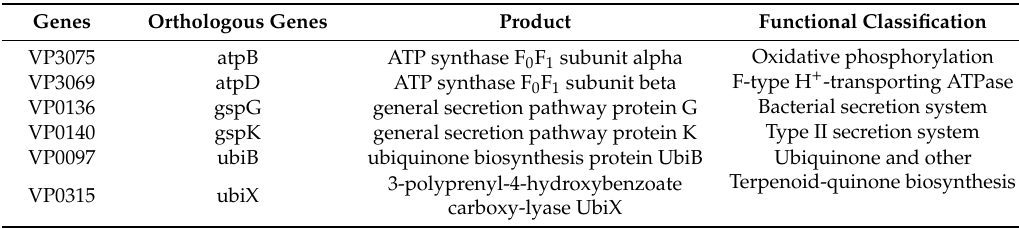
Table 1. Bacterial strains and plasmids used in this study.